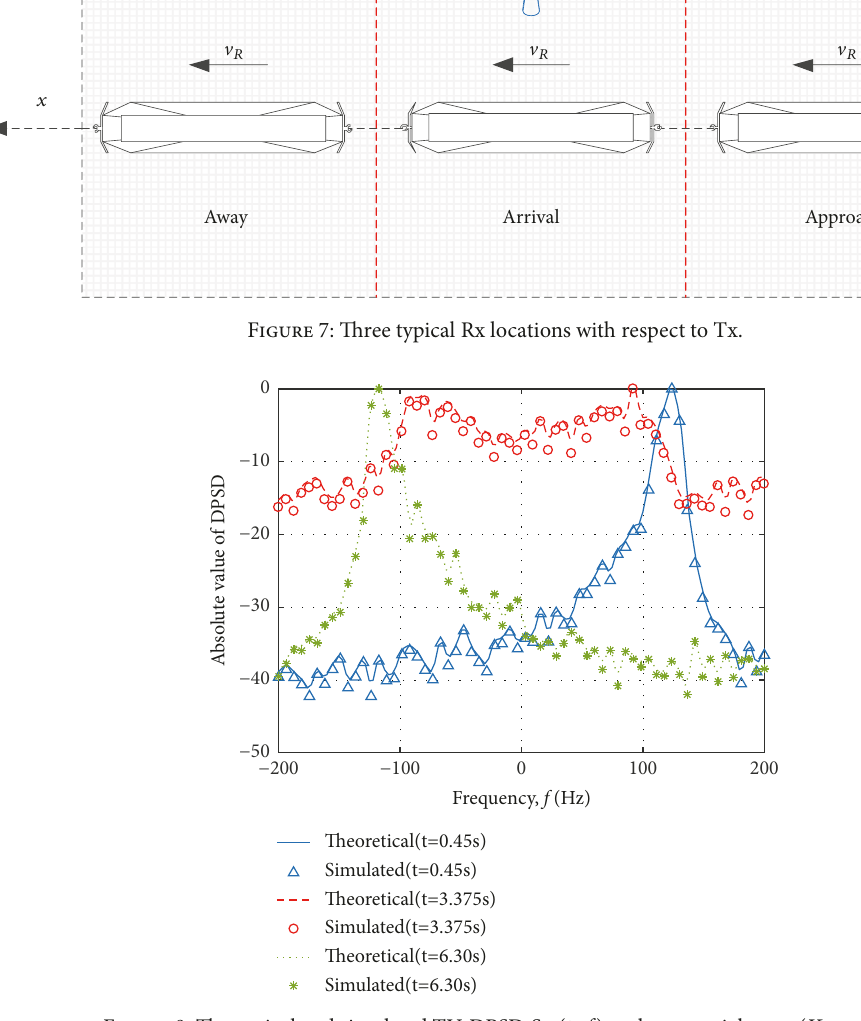
Figure 8: Theoretical and simulated TV-DPSD 𝑆 𝑝𝑞 (𝑡, 𝑓) at three special cases ( 𝐾 𝑝𝑞 =